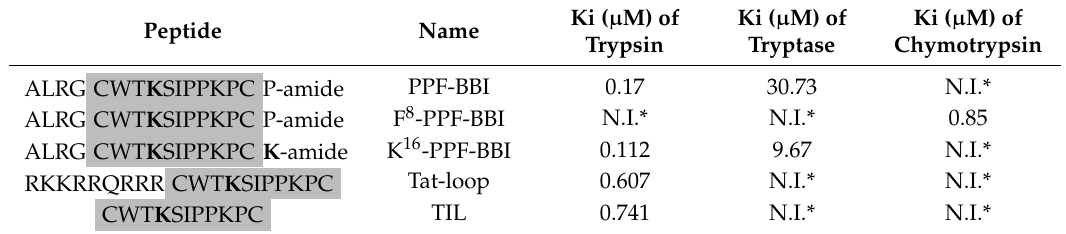
Table 2. PPF-BBI and its analogues against trypsin, chymotrypsin and tryptase. Peptide